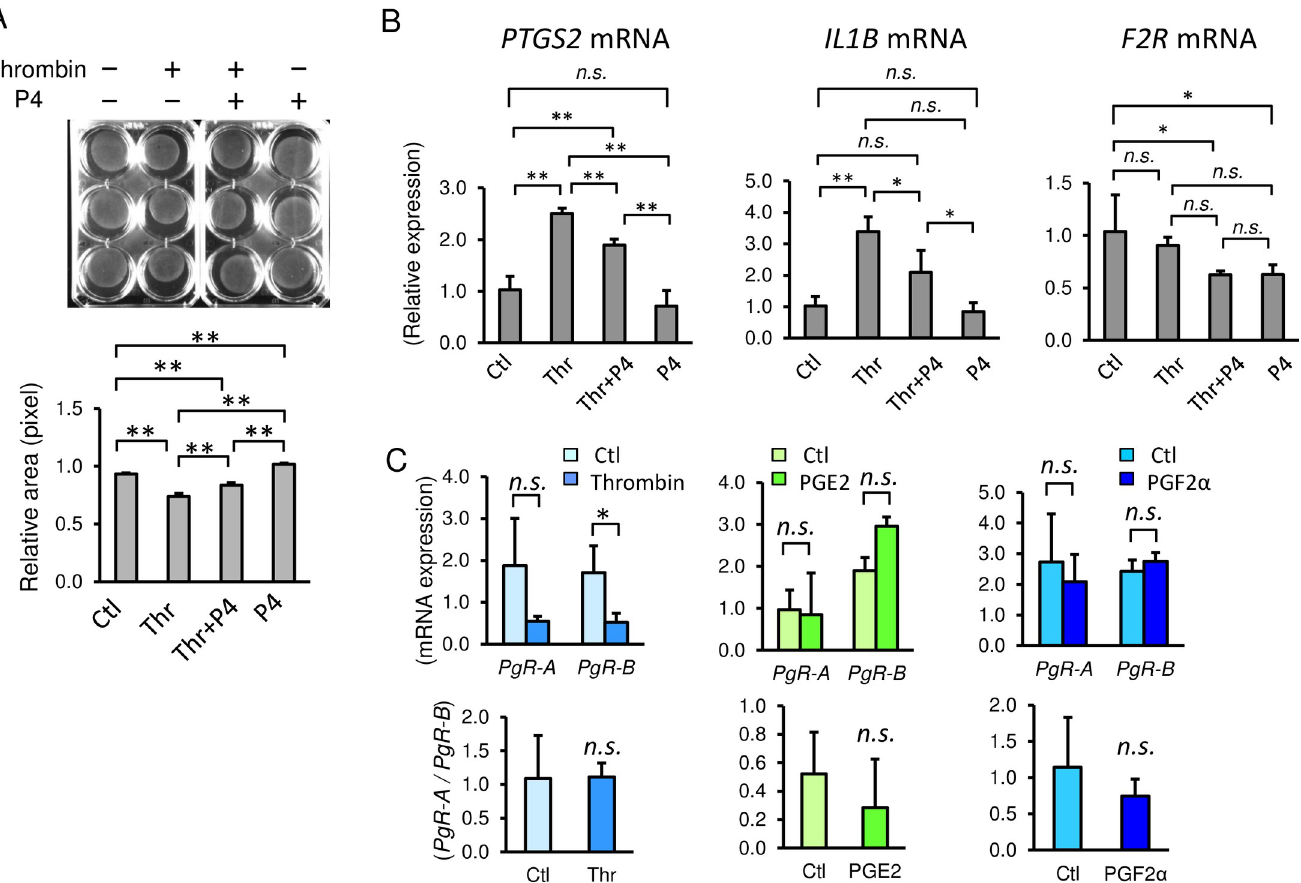
Fig 7. Effect of progesterone (P4) on thrombin-induced myometrial cell contractions. (A) Collagen lattice assay of myometrial cells at 30 min with 2 U/mL of thrombin (Thr) pretreated with 1 μ M progesterone (P4) for 1 h. Representative image (upper panel) and quantification of gel areas (lower graph). (B) Inhibition of thrombin-induced increases of PTGS2 , IL1B , and F2R mRNA by P4. Myometrial cells were pretreated with 1 μ M of P4 for 1 h, and then treated with 2 U/mL of thrombin. (C) Gene expressions of progesterone receptor-A and–B ( PgR-A and PgR-B ) with 24 h treatment of 1 U/mL of thrombin, 10 nM of PGE2, and 10 nM of PGF2 α (upper graphs) and PgR-A to PgR-B ratio (lower graphs). n = 3 in each group. � , p < 0.05, and �� , p < 0.01. The experiments were repeated three times.